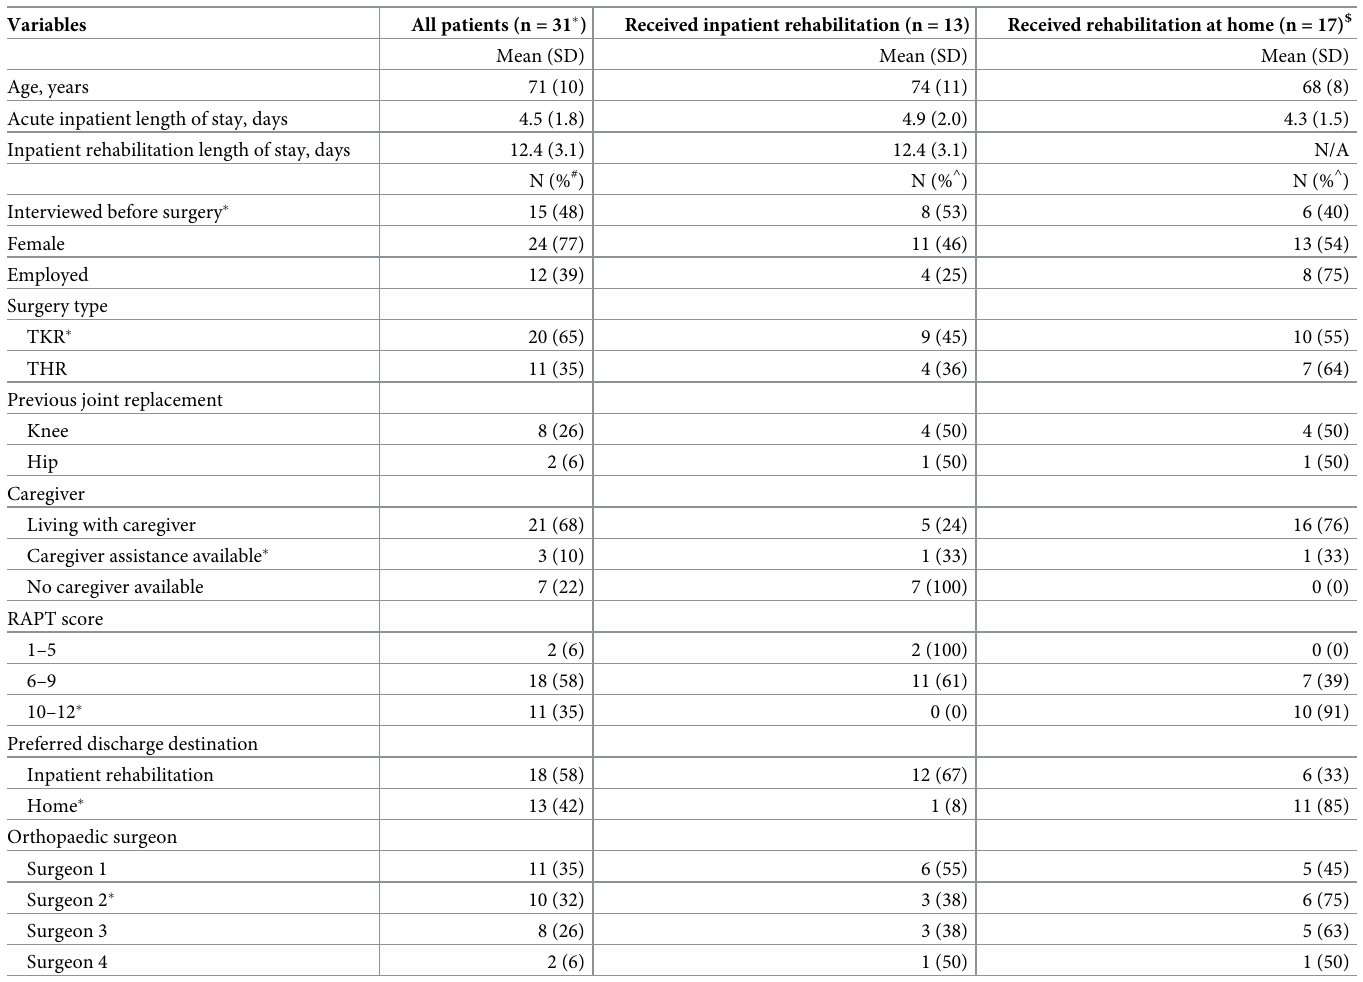
Table 1. Patient